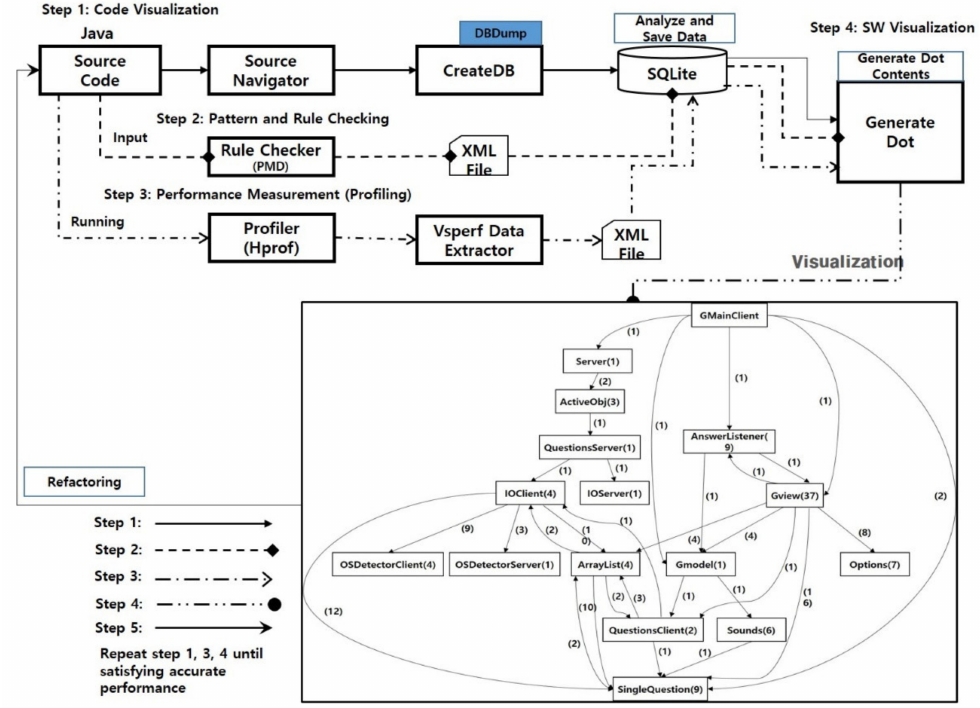
Figure 1. Performance measurement mechanism for Java code of cyber-physical system (CPS)-based tra ffi c control simulator. PMD, programming mistake